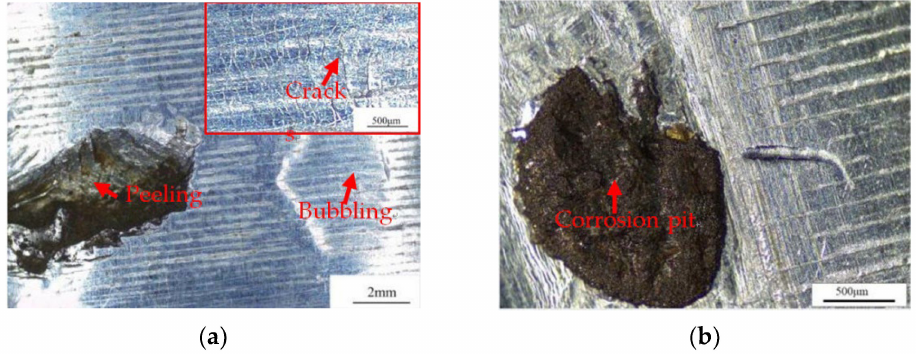
Figure 8. Macroscopic morphology observation: ( a ) damage form of the chromium layer and ( b ) corrosion